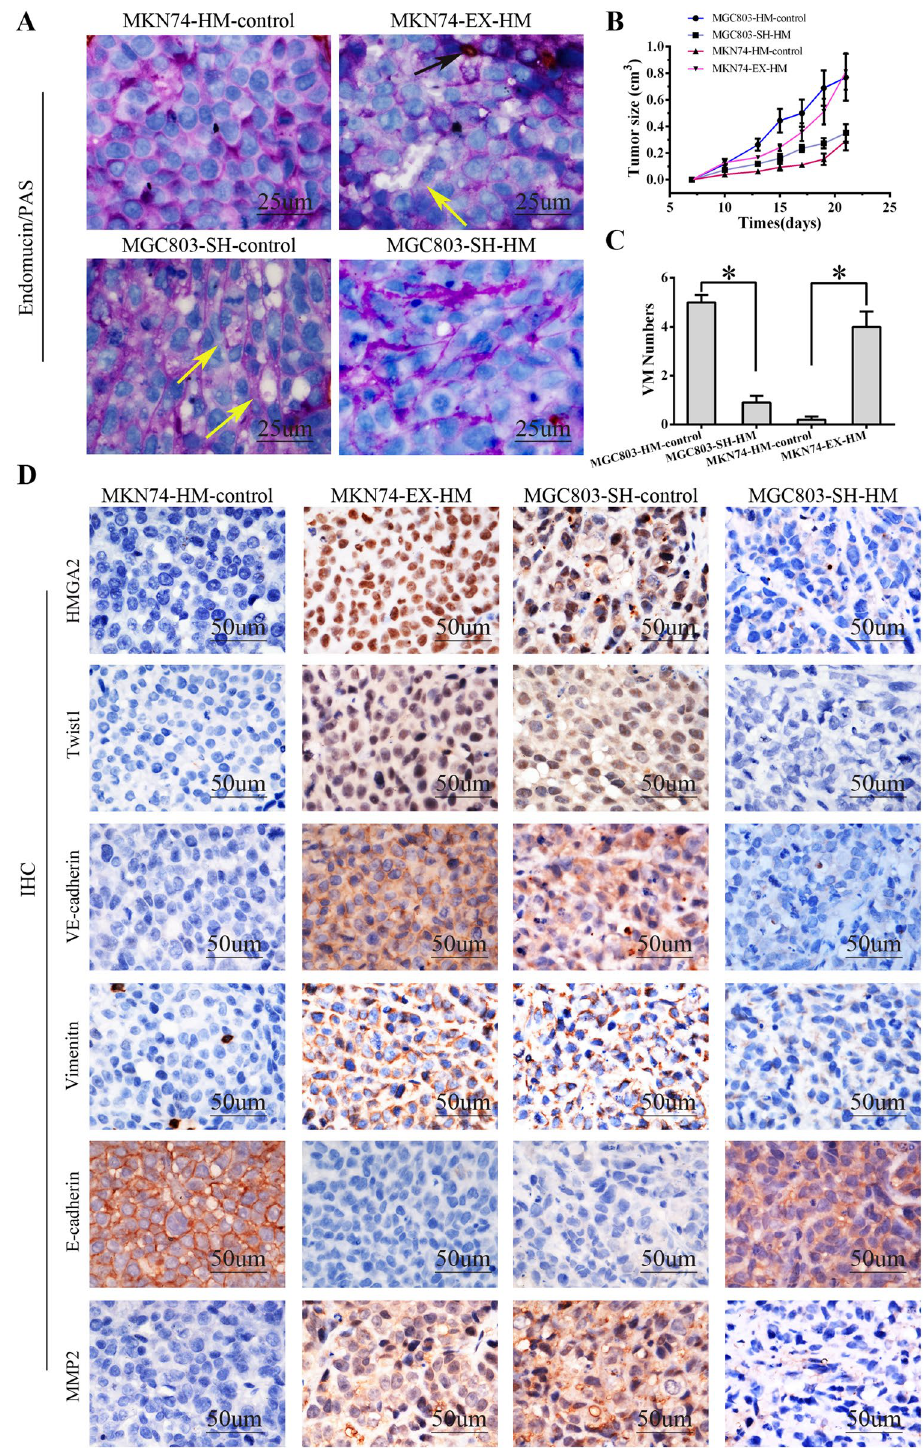
Figure 6. HMGA2 promotes tumour growth and vasculogenic mimicry in a xenograft tumour model. MKN74 cells stably transfected with HMGA2 expression plasmid and MGC803 cells stably transfected with the HMGA2 sh-RNA plasmid were subcutaneously injected into BALB/c-nu/nu mice. ( A ) EDV with Endomucin expression (the black arrow); VM channels with PAS-positive substance and negative Endomucin expression, and red cells remained visible at the center of the VM channels (the yellow arrow) (bar 25 um); ( B ) Tumour growth curve showed HMGA2 overexpression promotes tumor growth; ( C ) Tumours with HMGA2 overexpression have more VM tubes; ( D ) IHC staining showed that tumours with higher HMGA2 expression had elevated Twist1, VE-cadherin, vimentin, MMP2 expression and loss of E-cadherin proteins ( × 400, bar 50